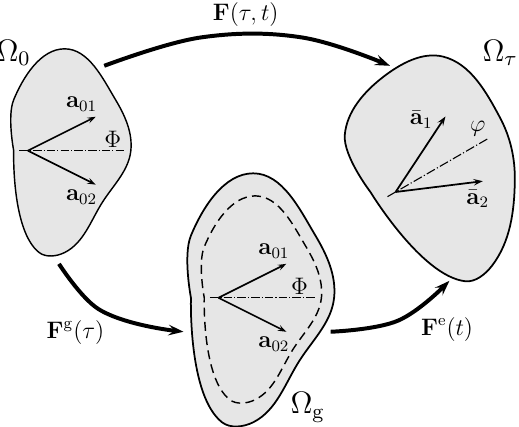
Figure 2. Kinematics of growth. Deformation gradient F ( τ , t ) maps reference configuration Ω 0 to the current configuration Ω τ . The growth tensor F g ( τ ) (with det F g = det F = ˆ v ) connects reference configuration Ω 0 to the intermediate stress-free configuration Ω g , which accounts for the volume change at the long time-scale τ . Then, the elastic deformation tensor F e ( t ) connects Ω g to the current configuration Ω τ . That is, the total deformation gradient F ( τ ) is split into volumetric growth part F g and elastic part F e